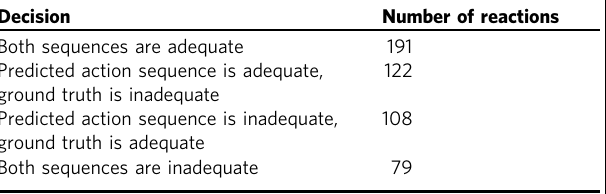
Table 6 Result of the chemist ’ s assessment of action sequences. Decision Number of